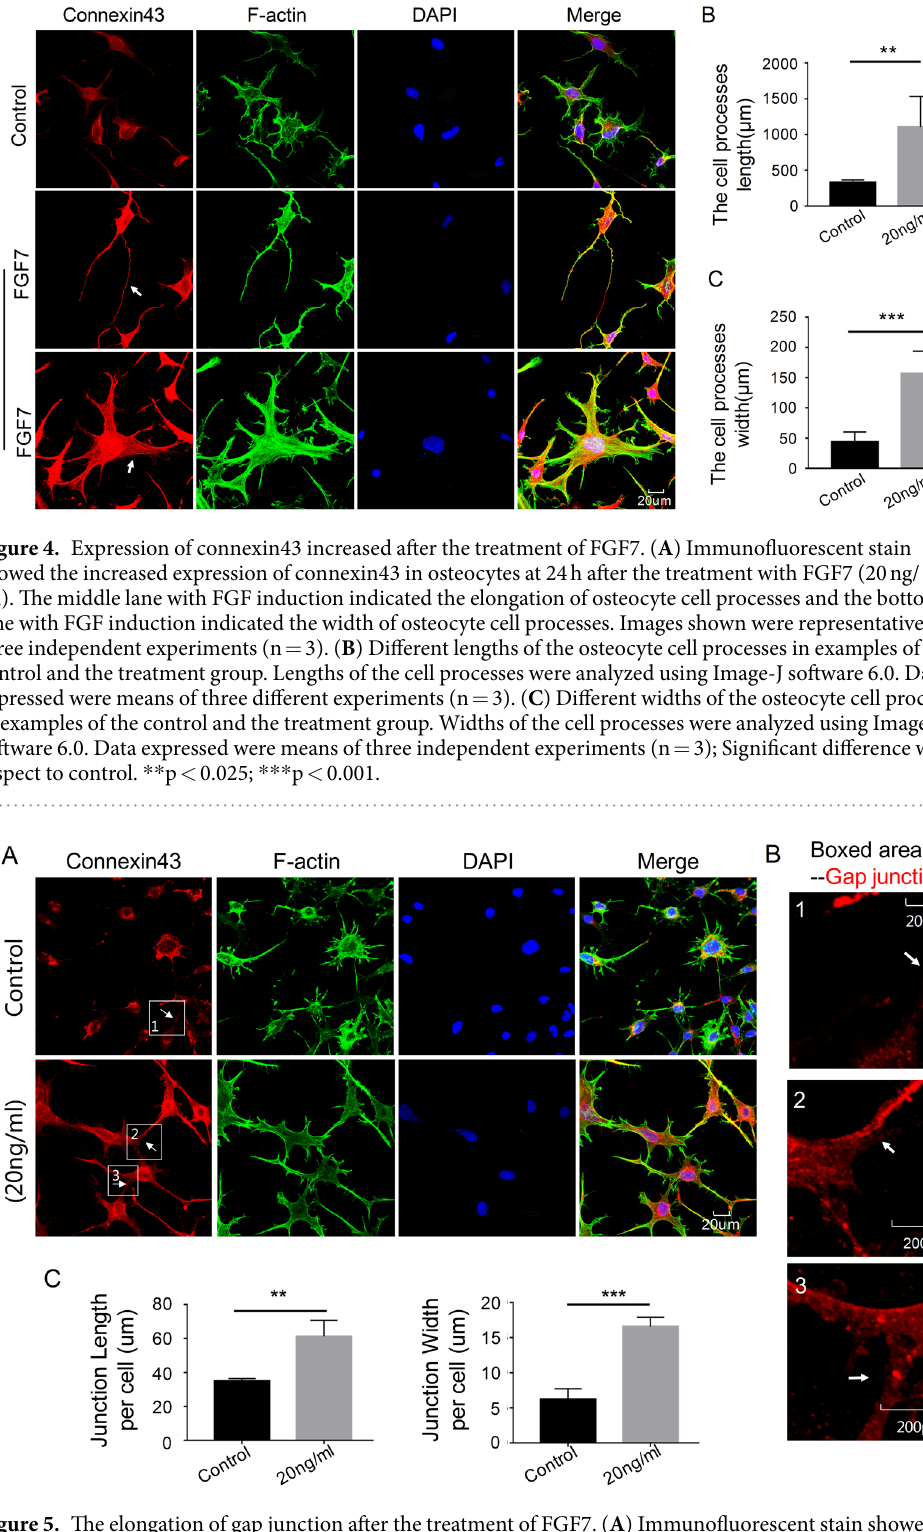
Figure 5. The elongation of gap junction after the treatment of FGF7. ( A ) Immunofluorescent stain showed the elongation of gap junction between osteocytes at 24 h after the treatment with the FGF7 (20 ng/ml). Images shown were representative of three different experiments (n = 3). ( B ) The higher magnification of boxed area showed the elongation of gap junction, as the white arrow indicated. ( C ) Different lengths and widths of the gap junction per cell in examples of the control and the treatment group. The quantitative data were analyzed using Image-J software 6.0. Data expressed were means of three independent experiments (n = 3). Significant difference with respect to control. ** p < 0.025; *** p <